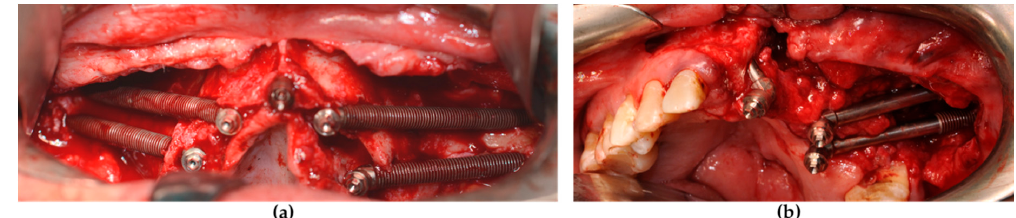
Figure 2. The zygomatic implant was placed and the conical abutment was screwed before suturing. ( a ) The standard type of zygomatic implant was used for patients with maxillary atrophy. ( b ) An oncologic type of zygomatic implant with a machined coronal part was used for implant sites that lacked crestal bone.